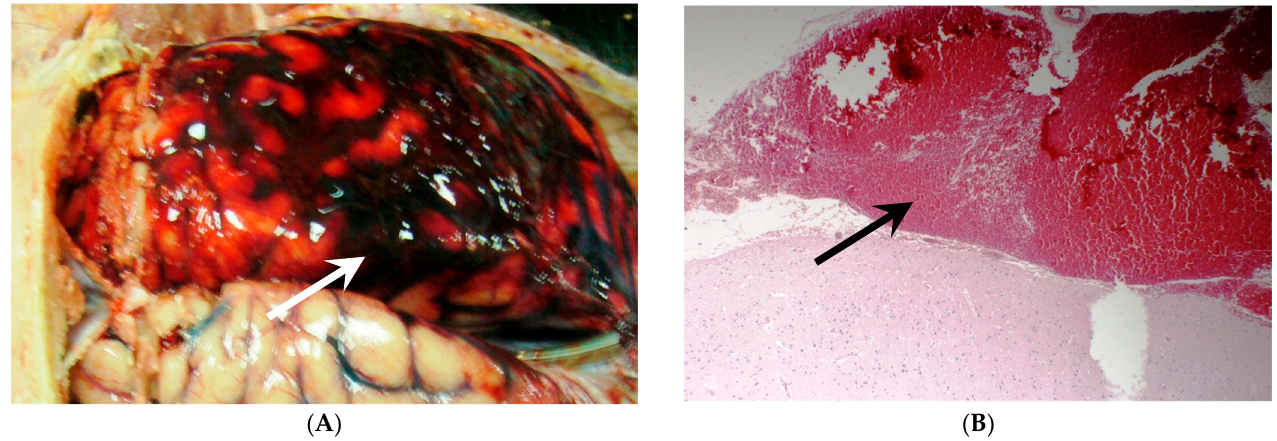
Figure 1. Subarachnoid hemorrhage. The arrows indicate both macroscopic ( A ) and microscopic ( B ) large bleeding (H&E × 10).